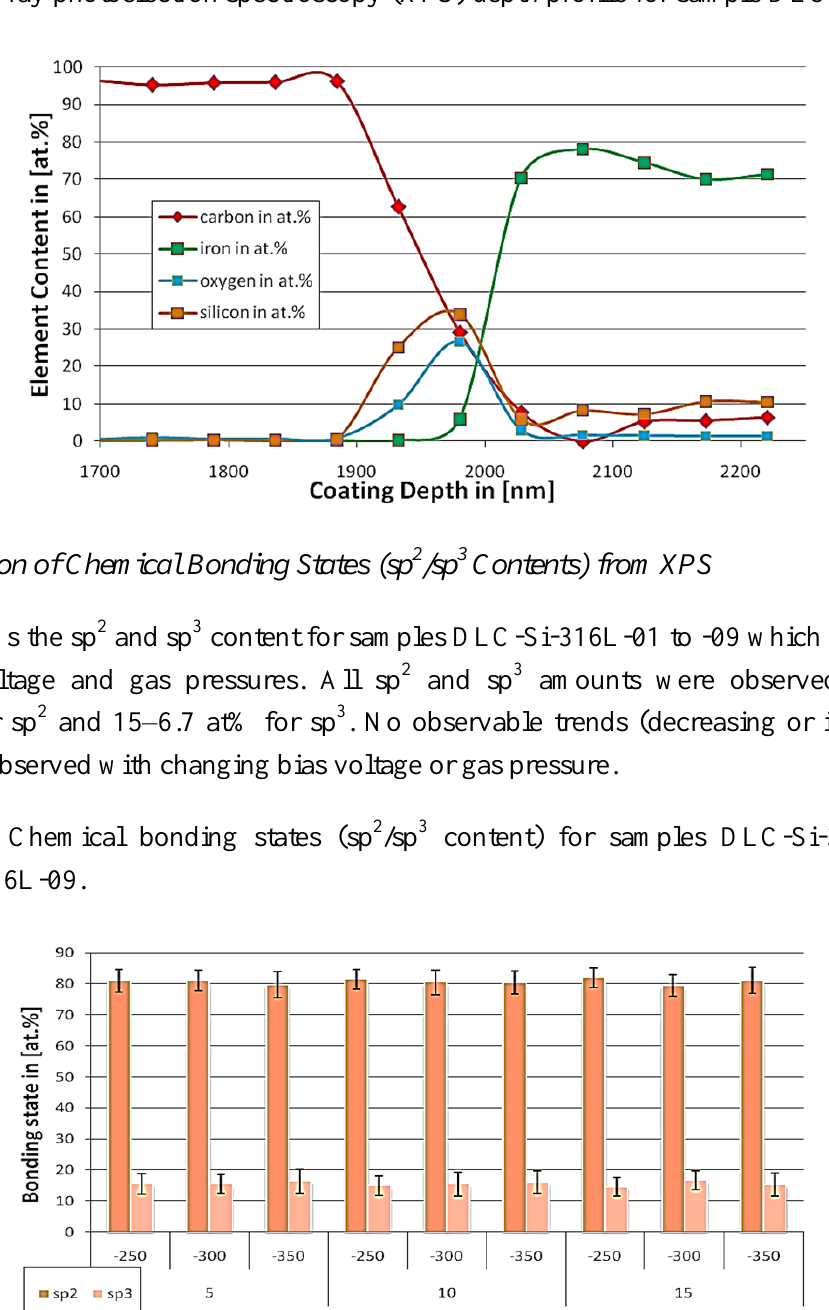
Figure 1. X-ray photoelectron spectroscopy (XPS) depth profile for sample DLC-Si-316L-01.